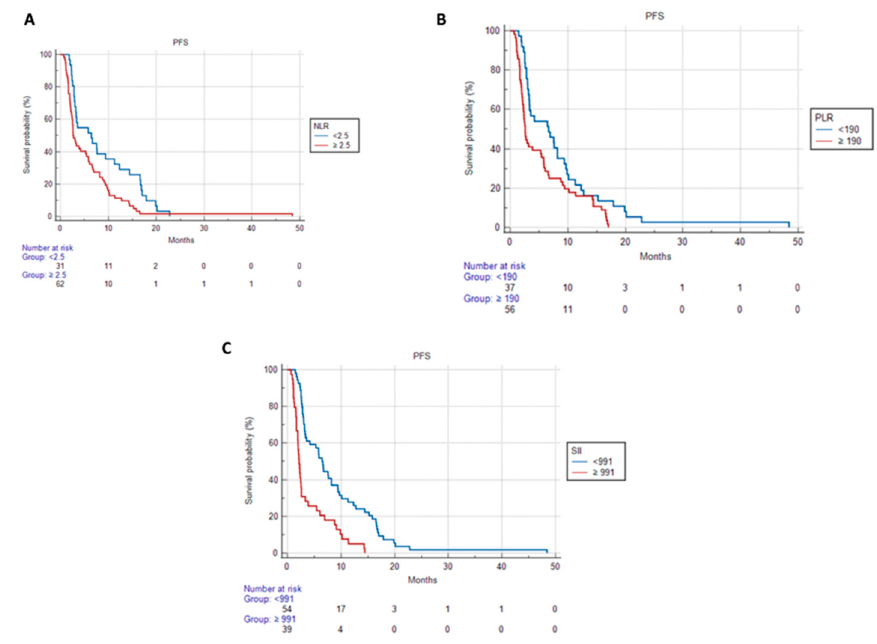
Figure 2. PFS according to ( A ) NLR, ( B ) PLR, and ( C ) SII.